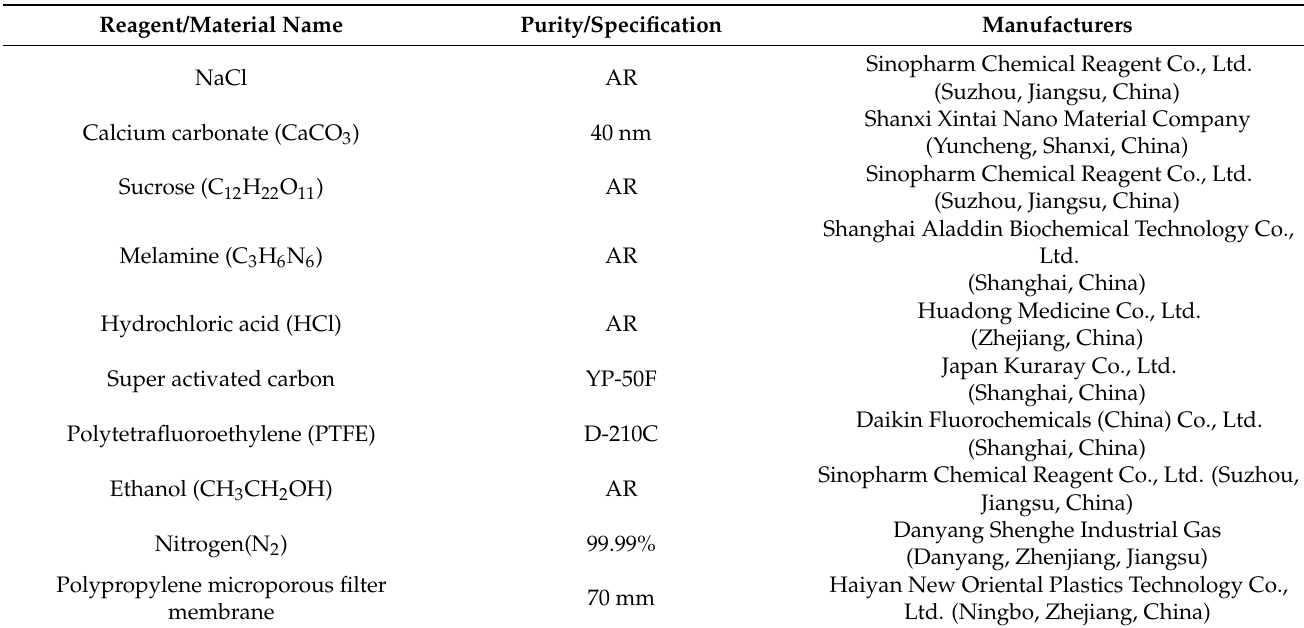
Table 1. Experimental reagents and